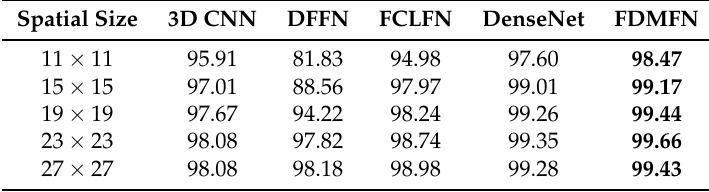
Table 12. Overall accuracy (in %) obtained by different approaches on the KSC dataset when considering different spatial sizes of input patches. The best results are highlighted in bold